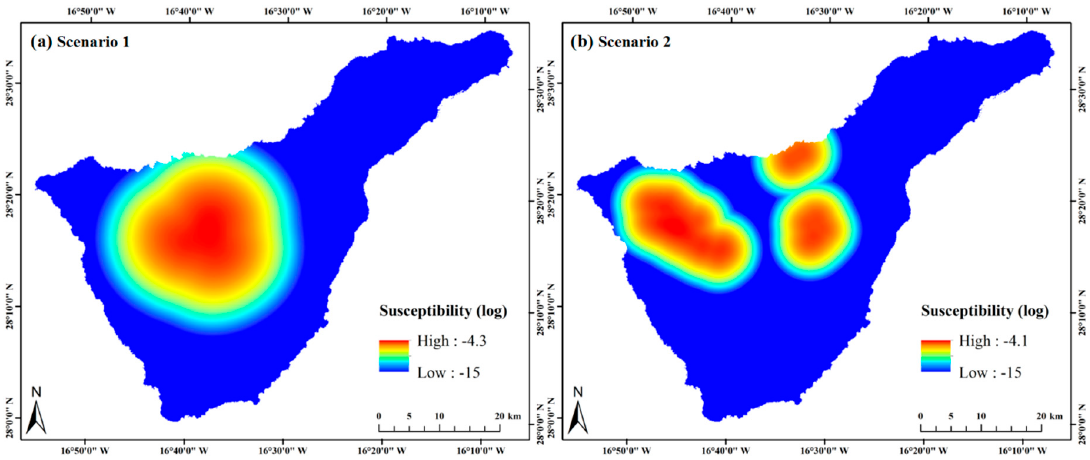
Figure 5. The vent susceptibility maps indicating the probabilities of future vent locations. ( a ) Susceptibility for Scenario 1. ( b ) Susceptibility for Scenario